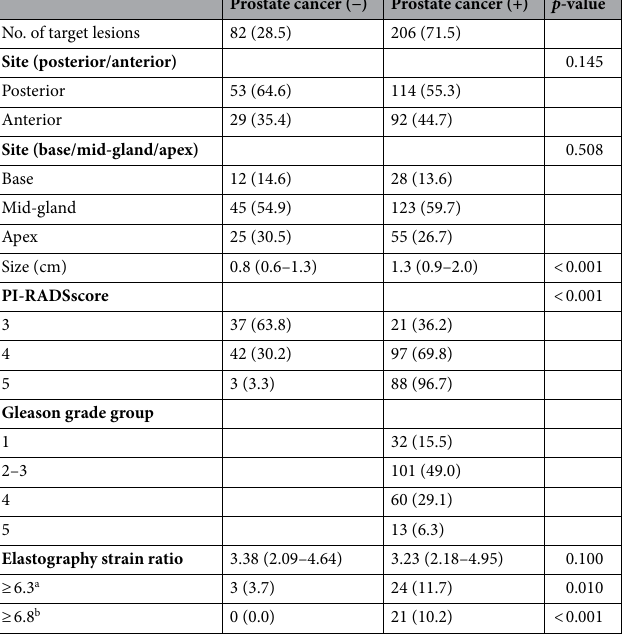
Prostate cancer (−) Prostate cancer (+) p